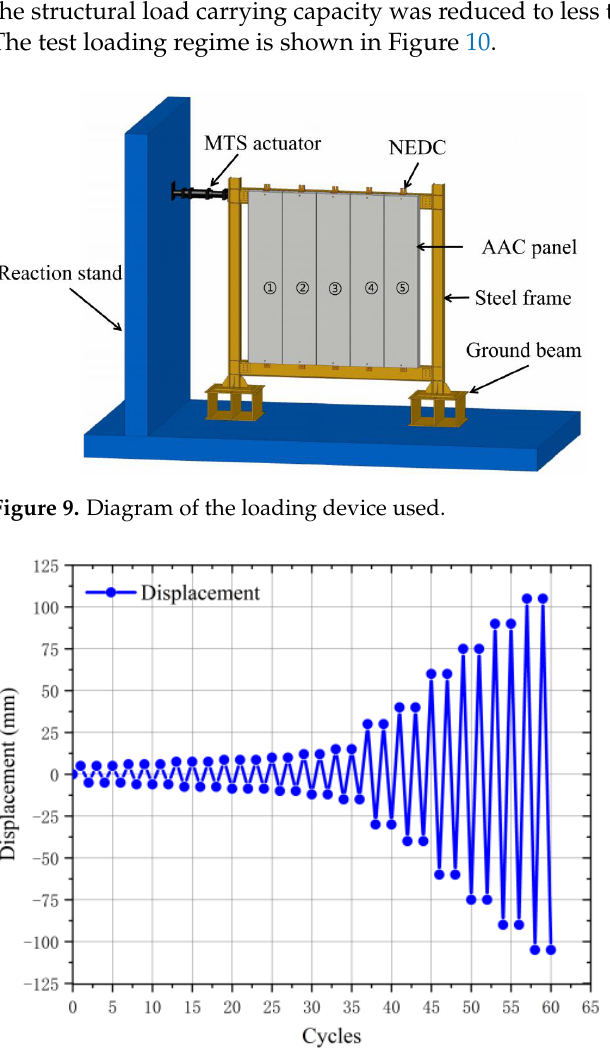
8 of 21 Figure 8. Images depicting the different stages of test piece installation: ( a ) installation of the steel frame; ( b ) installation of AAC wall panels; ( c ) installation of bolts; ( d ) application of mortar in AAC